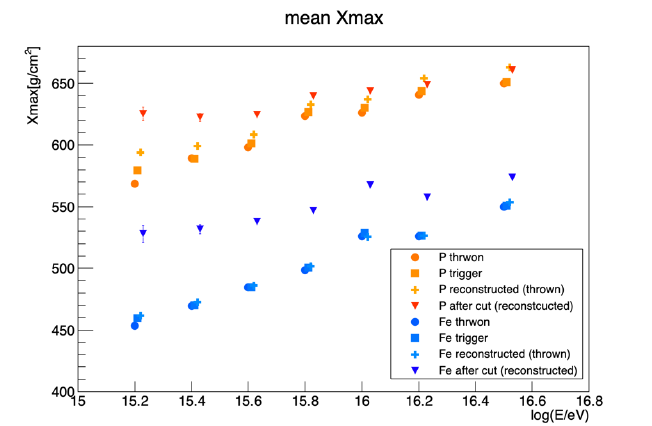
Figure 5: The event distribution of core position (upper left), zenith angle (upper right), azimuth angle (lower left), and X max (lower right).